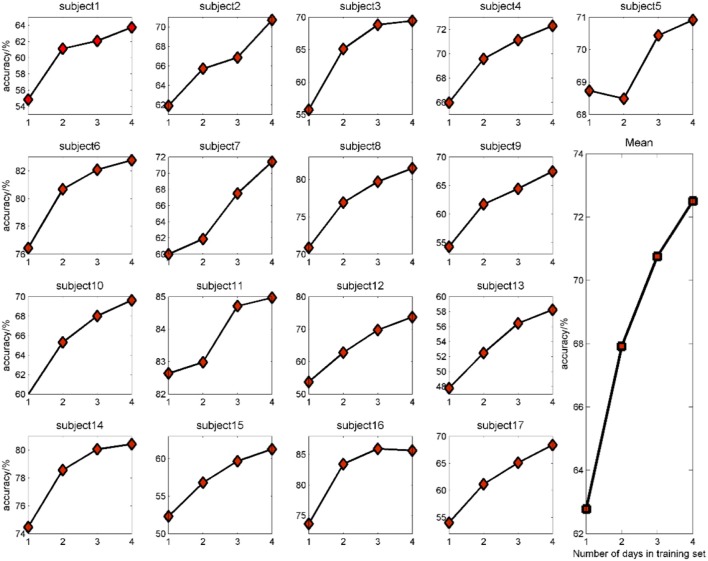
Classification accuracy with different number of days in the training set for all the subjects.